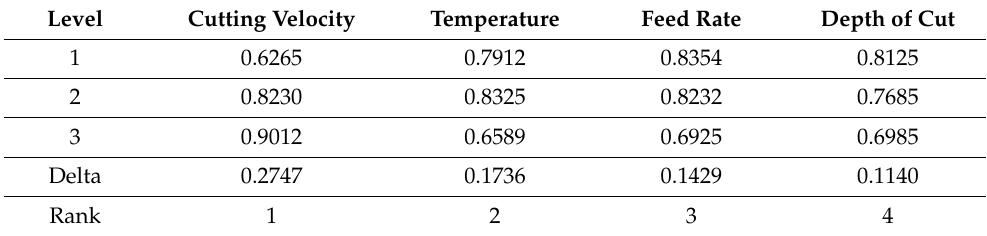
Table 12. Response table for preferred solution